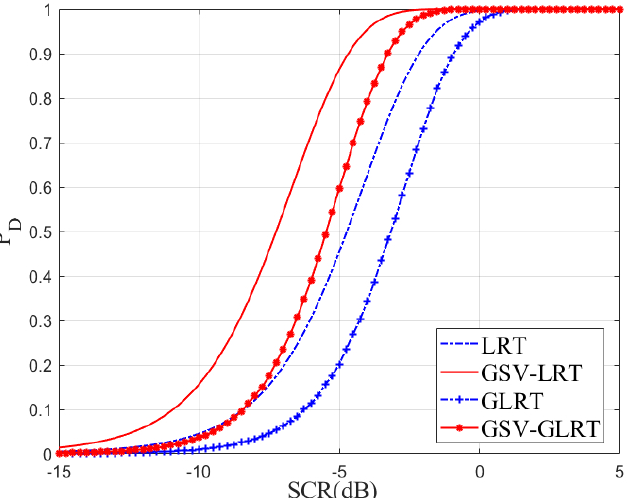
Figure 4. Detection probability versus SCR, V r = 2 m/s, CNR =10 dB, P FA = 10 − 4 ,three channels, b1 = 0 m, b2 = 0.15 m, b3 = 0.3 m, β = [ 0.6,0.6,1,0.2,0.2 ] T ⊗ 1 3